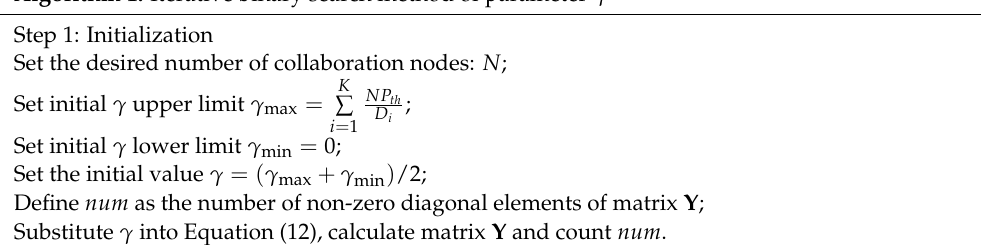
Algorithm 1: Iterative binary search method of parameter